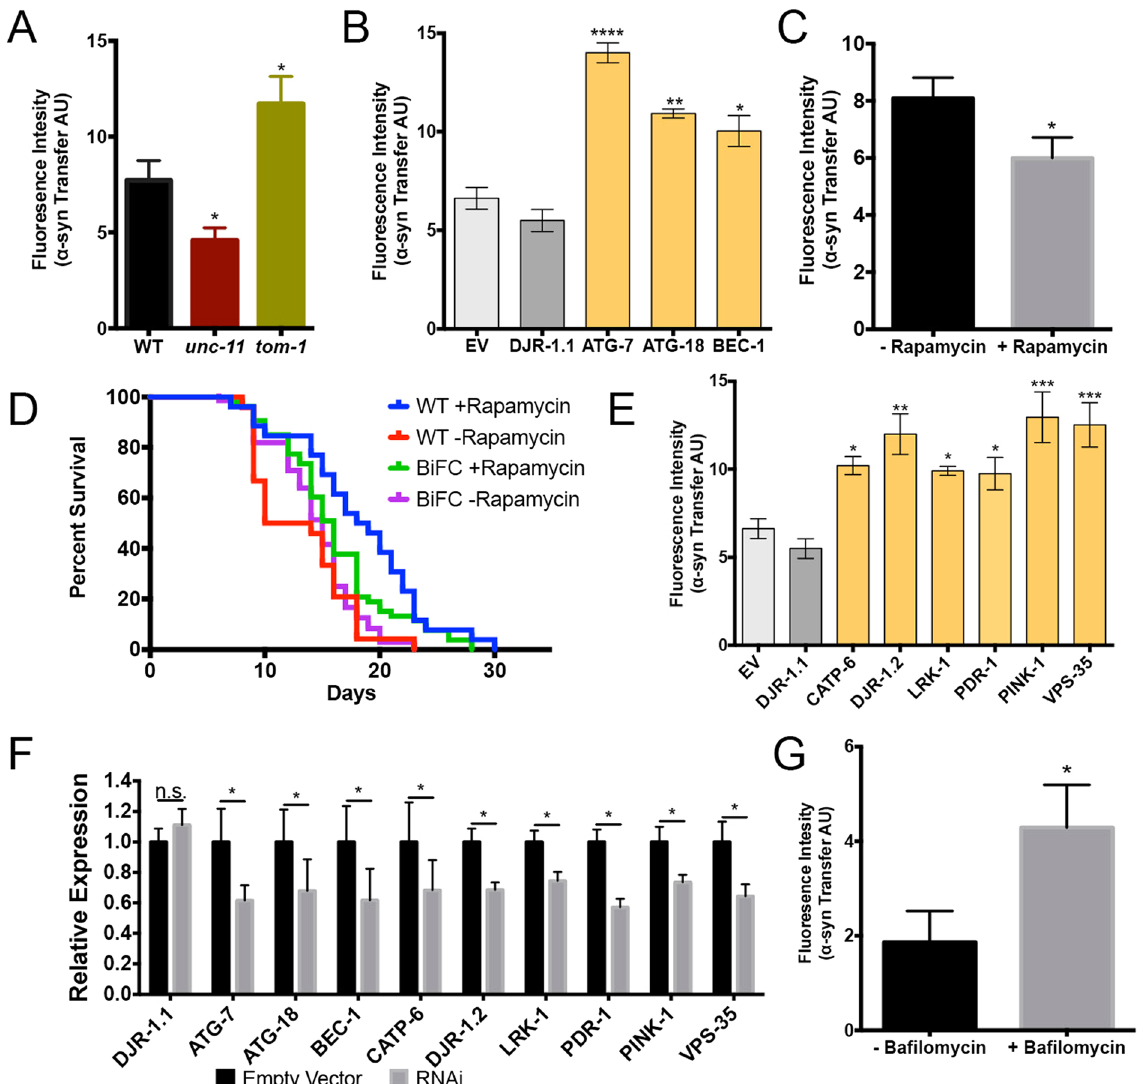
Figure 4. Neuron-to-neuron transfer of a-syn requires synaptic transmission and is increased by disruption of autophagy or PD-associated genes. ( A ) Quantification of BiFC-induced fluorescence in BiFC-syn (WT) worms compared to BiFC-syn worms crossed with unc-11 and tom-1 mutant strains. ( B ) Quantification of BiFC- induced fluorescence in BiFC-syn worms crossed into the neuronal RNAi sensitive TU3401 strain following RNAi by feeding on HT115 bacteria expressing dsRNA of the respective autophagy related genes of interest. EV: Empty Vector control (light grey), DJR-1.1: off-target control, C. elegans isoform of DJR-1 expressed primarily in intestine (dark grey). ( C ) Quantification of BiFC-induced fluorescence in the head region of the worm of BiFC-syn worms following rapamycin treatment. ( D ) Lifespan of N2 and BiFC-syn worms following rapamycin treatment and without. ( E ) Quantification of BiFC-induced fluorescence in BiFC-syn worms crossed into the neuronal RNAi sensitive TU3401 strain following RNAi by feeding on HT115 bacteria expressing dsRNA of the respective autophagy related genes of interest. EV: Empty Vector control (light grey), DJR-1.1: off-target control. ( G ) Quantification of BiFC-induced fluorescence in the head region of the worm of BiFC-syn worms following bafilomycin treatment. ( A–C,E,G ) Statistical significance was determined from the mean values of three independent experiments with at least 75 worms per group, using ANOVA in conjunction with a Tukey’s post- hoc multiple comparisons test (alpha = 0.05). ( F ) mRNA expression levels of genes following RNAi knockdown. Statistical significance was determined from the mean values of three independent qPCR experiments using ANOVA in conjunction with a Tukey’s post-hoc multiple comparisons test (alpha = 0.05). In all cases data is represented as mean of 3 independent experiment, represented as mean ±